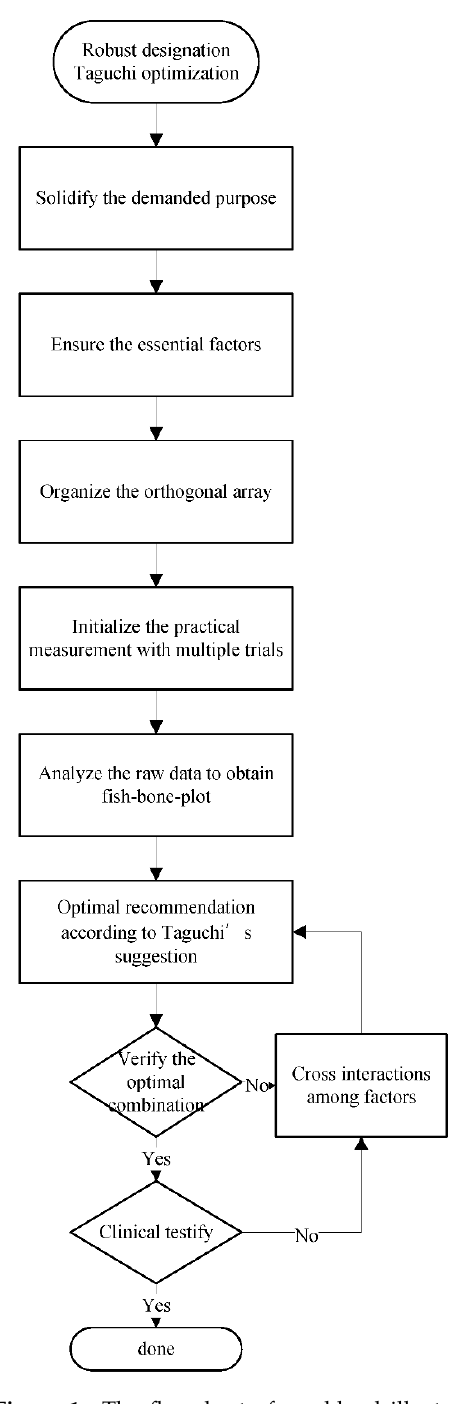
Figure 1. The flowchart of workload illustrates how researchers apply Taguchi’s optimization methodology to ultrasound facilities in practice.